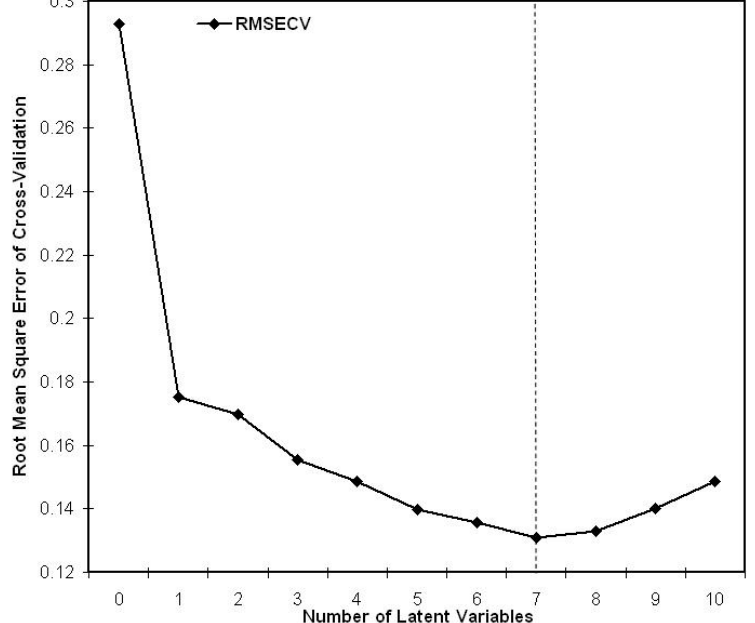
Figure 5. Variation of the root mean square error of cross validation (RMSECV) of models based on PLSR as a function of the number of latent